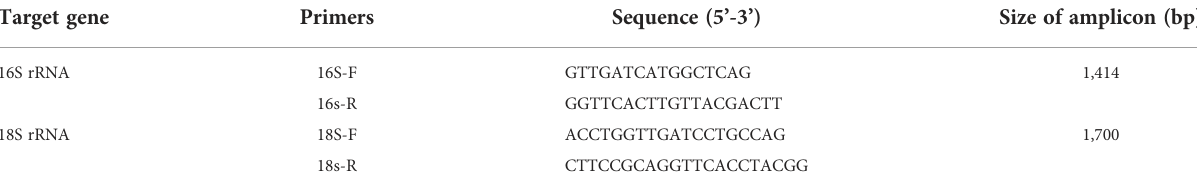
TABLE 1 List of primers used for ampli fi cation of the standardized 16S and 18S rRNA gene. Target